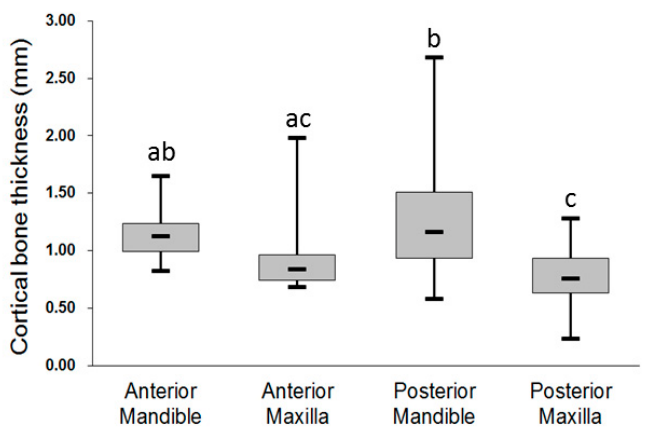
Figure 2. Thickness of the crestal cortical bone at the four jawbone regions for the younger group. Post hoc pairwise comparisons were conducted using Tukey’s test; use of the same letter (a, b, c) indicates no significant difference at the 0.05 level.